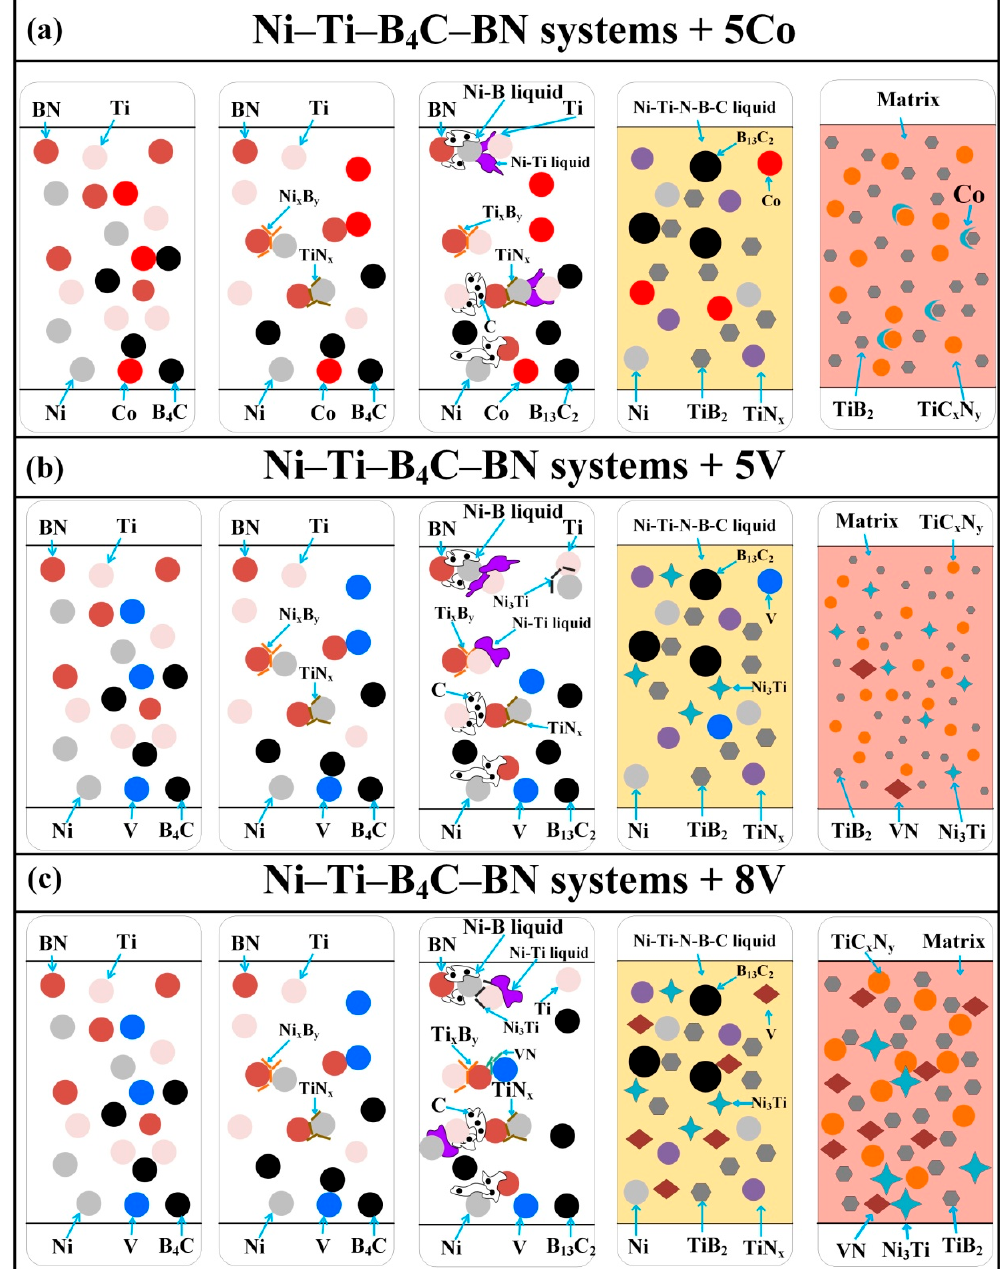
Figure 10. Reaction mechanism diagram of Ni–Ti–B 4 C–BN systems ( a ), ( b ) and ( c ) are the reaction mechanisms of Ni–Ti–B 4 C–BN systems with 5 wt.% Co, 5 wt.% V and 8 wt.% V, respectively.